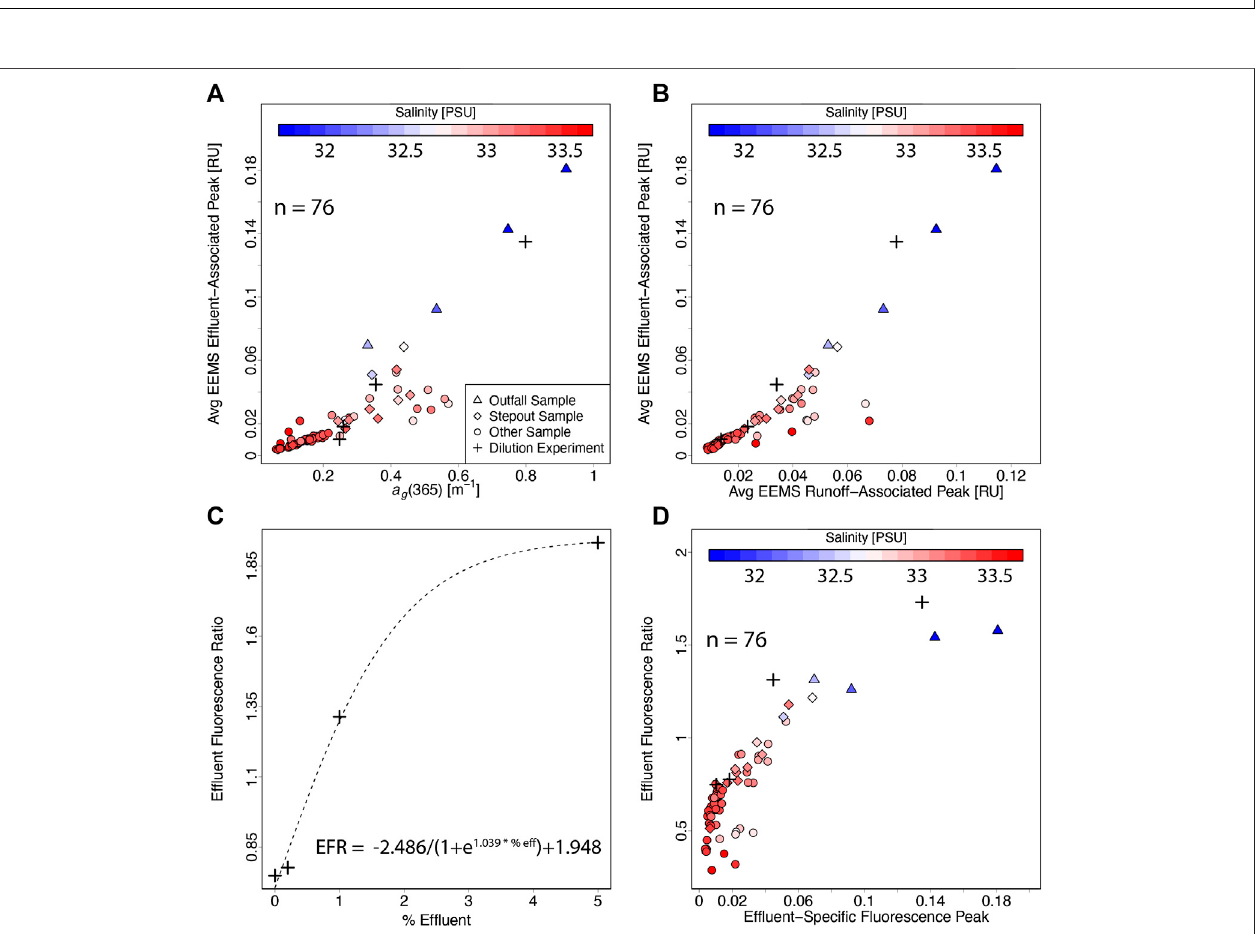
FIGURE6| Relationshipsbetween: (A) intensityoftheef fl uent-associated fl uorescencepeak F E and a g (365), (B) intensityofef fl uent-associated fl uorescencepeak F E andintensityoftherunoff-associated fl uorescencepeak F R , (C) theef fl uent fl uorescenceratio EFR (cid:2) F E / F R and the%ef fl uent byvolume fromthedilutionexperiment samples, and (D) the EFR and a g (365).